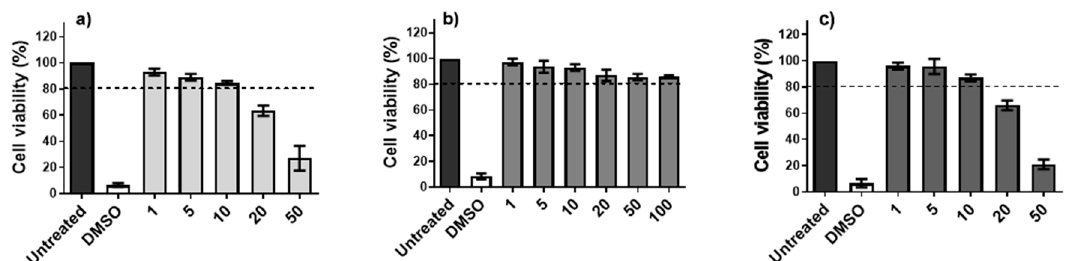
Figure 1. Biocompatibility of AMC6 nanoparticle, G4-70/30 dendrimer, and Cy5.5-labeled G4- 70/dendrimer in DCs. The viability of monocyte derived-DCs was evaluated by MTT assay 48 h after exposure to ( a ) AMC6 nanoparticle, ( b ) G4-70/30 dendrimer, and ( c ) G4-70/30-Cy5.5 labeled dendrimer. The limit of toxicity was established at 80% of cell viability (dotted line). 10% DMSO was used as control for cell death. The data represent mean ± standard deviation of 3 different experiments.